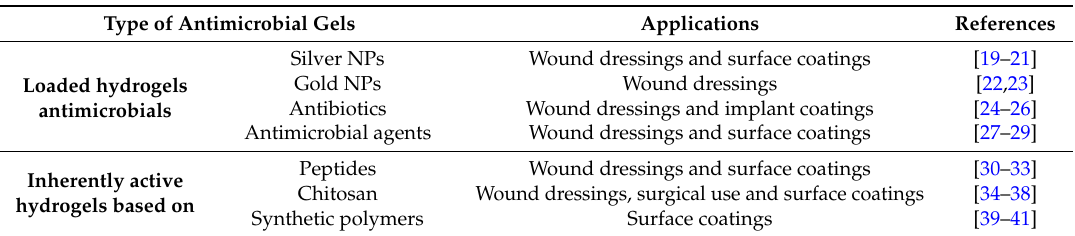
Table 1. Summary of the strategies reported to fabricate antimicrobial hydrogels. Reproduced with permission from